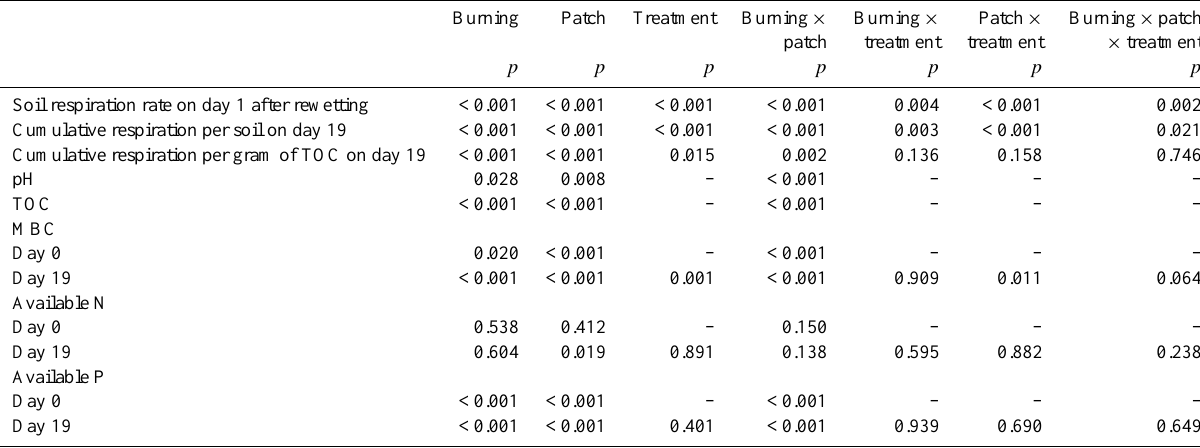
Table A1. Outputs of two-way or three-way analysis of variance (ANOVA) analyses of effects of burning (unburnt and burnt), patch (under shrubs, in open areas and under trees) and treatments (constantly moist or drying–rewetting) on cumulative respiration per soil, cumulative respiration per gram of TOC, soil respiration rate on day 1 after rewetting soil, ratio of cumulative respiration per gram of TOC in DRW to that in the CM treatment, MBC and available N and P (day 0 and day